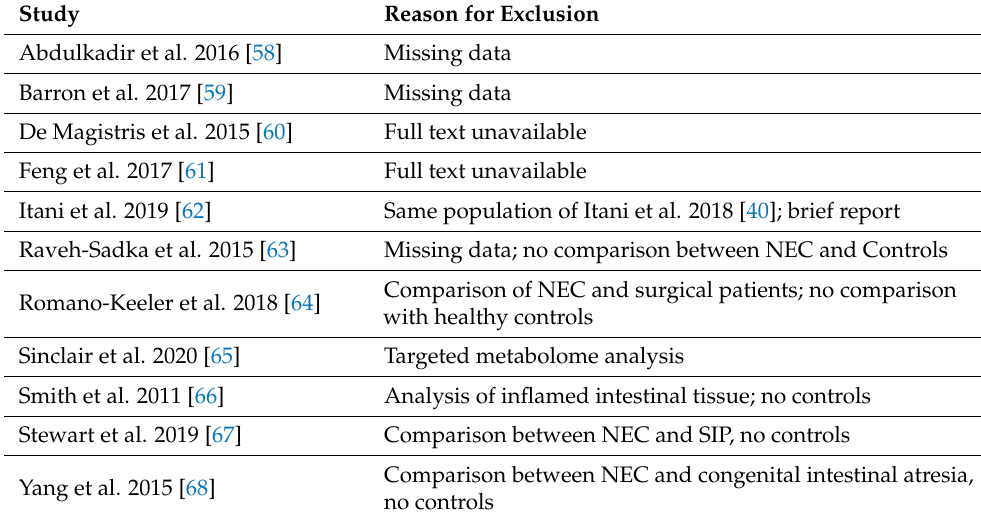
Table 3. Articles not eligible for qualitative analysis and reasons for